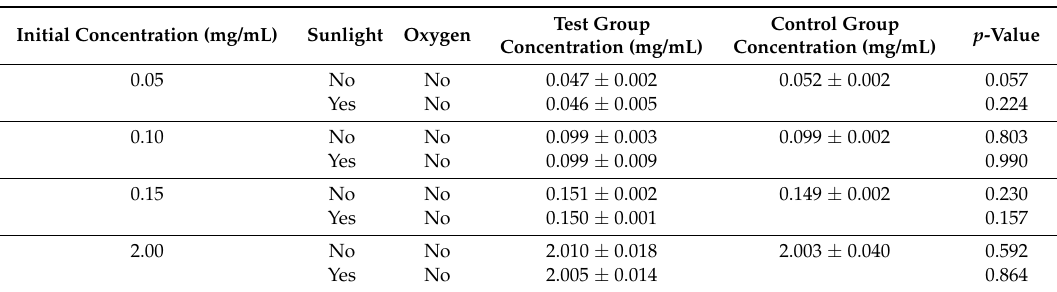
Table 5. EGCG degradation in EGCG solution atomized by ultrasonic scaler without oxygen: A between-group